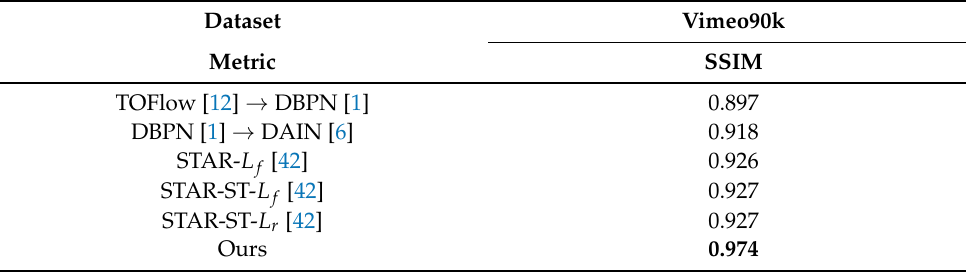
Table 3. Comparison with STAR